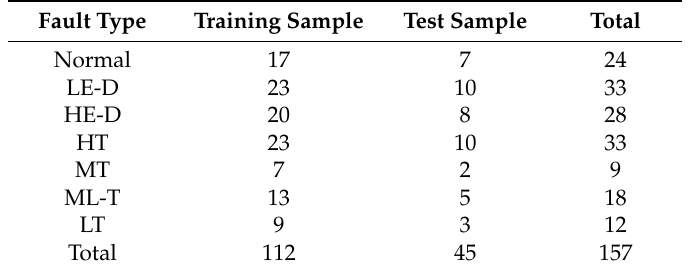
Table 1. Statistics of samples for training and testing, corresponding to various types of real